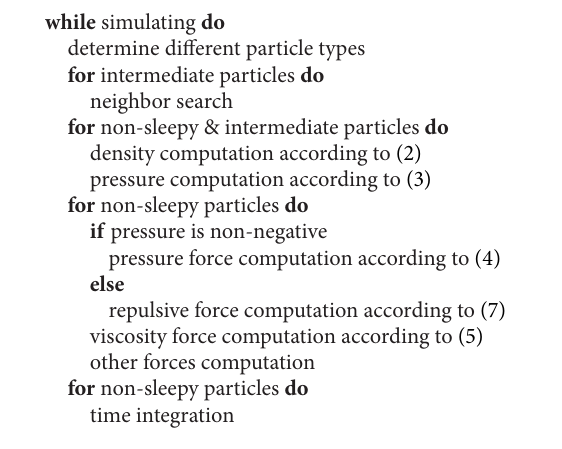
Algorithm 2: Sleepy SPH/WCSPH